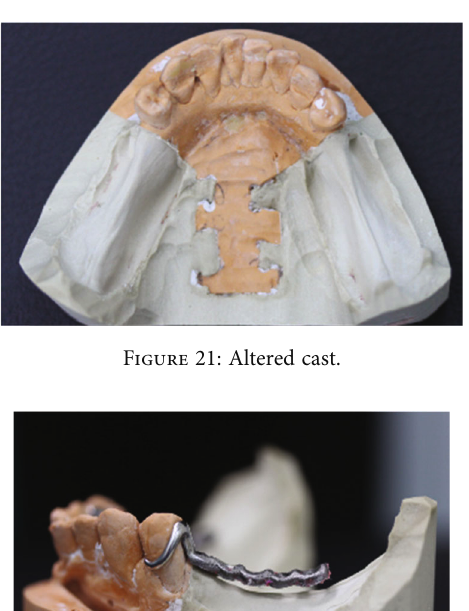
Figure 19: (a) Section the free end saddle on the master cast and create notches. (b) Attach the metal framework on the master cast.